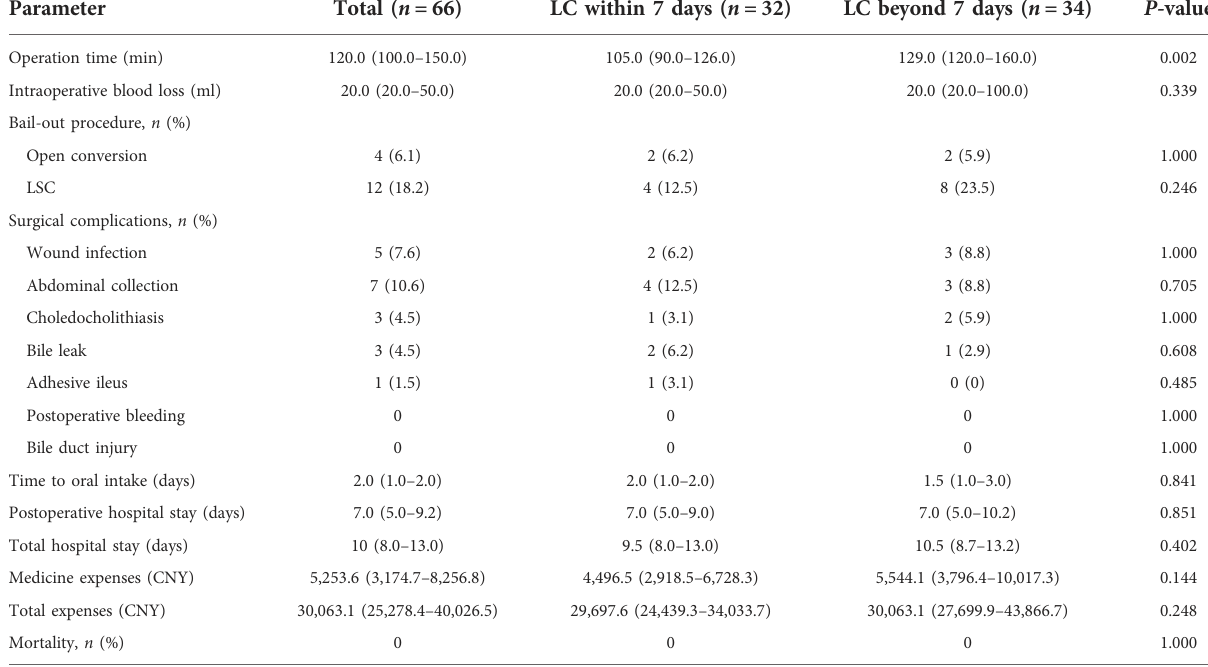
TABLE 2 Comparison of operative outcomes of LC between the within 7 days and beyond 7 days groups.